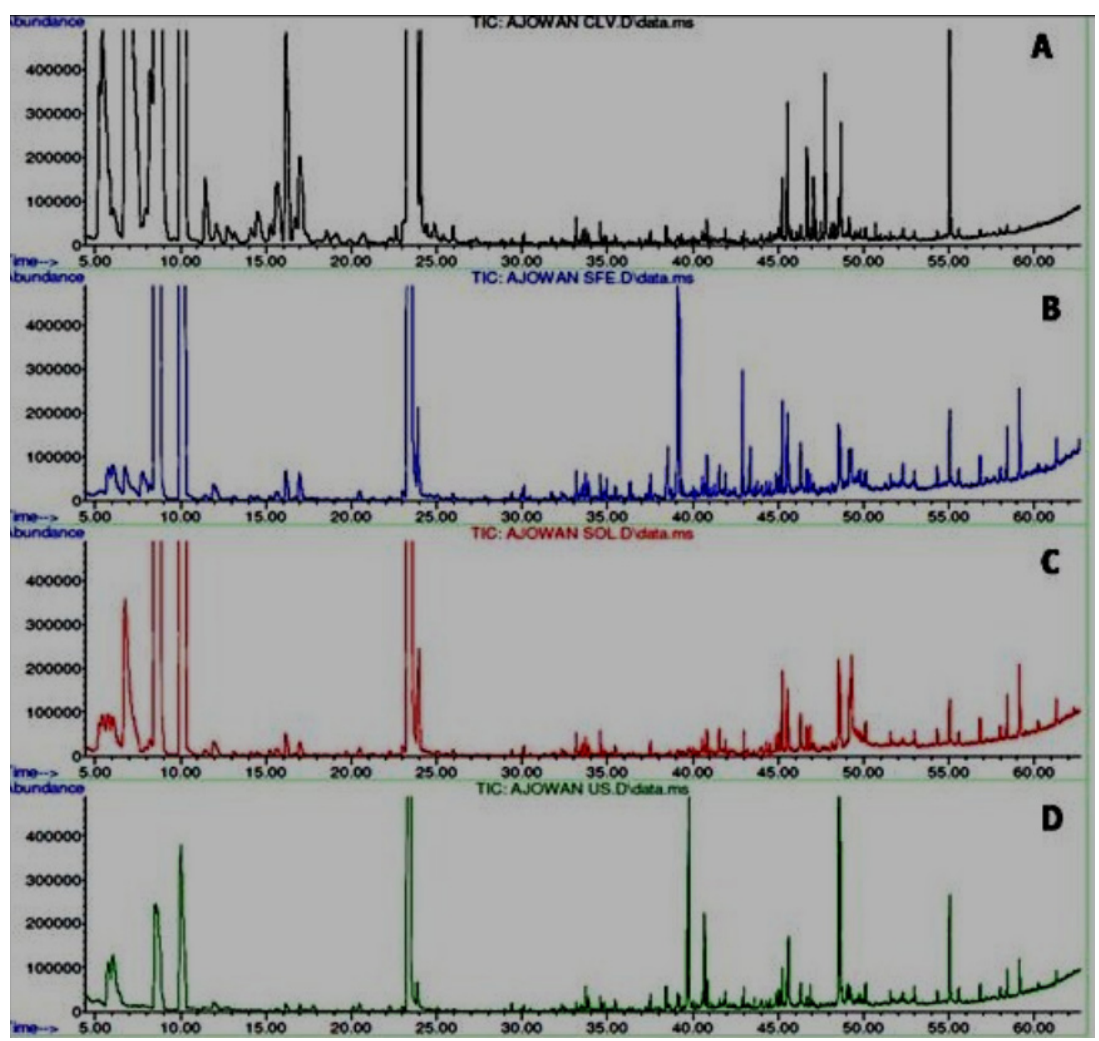
Figure 5. Comparative GC ‐ MS chromatograms of different oils of T. ammi L. extracted using different extraction techniques. ( A ) Hydrodistilled oil, ( B ) Solvent extracted oil, ( C ) Ultrasonicated oil, ( D ) SC ‐ CO 2 oil.